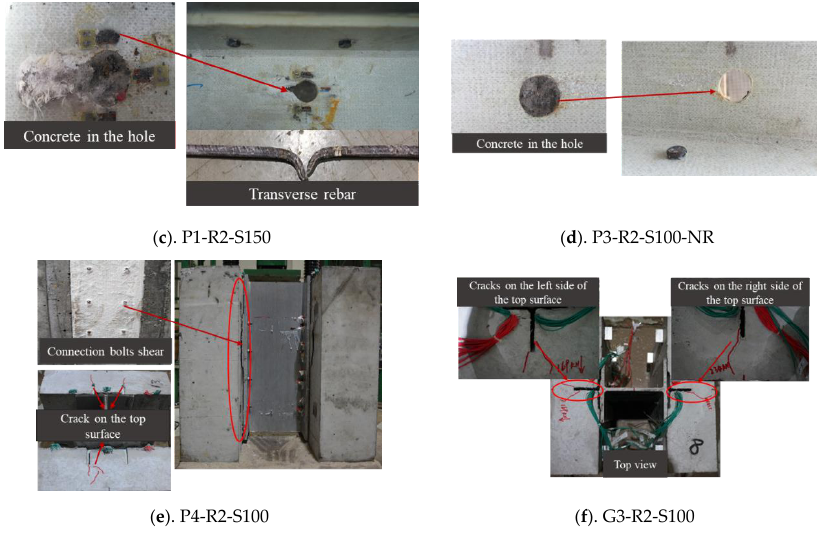
Figure 6. Failure of specimens.